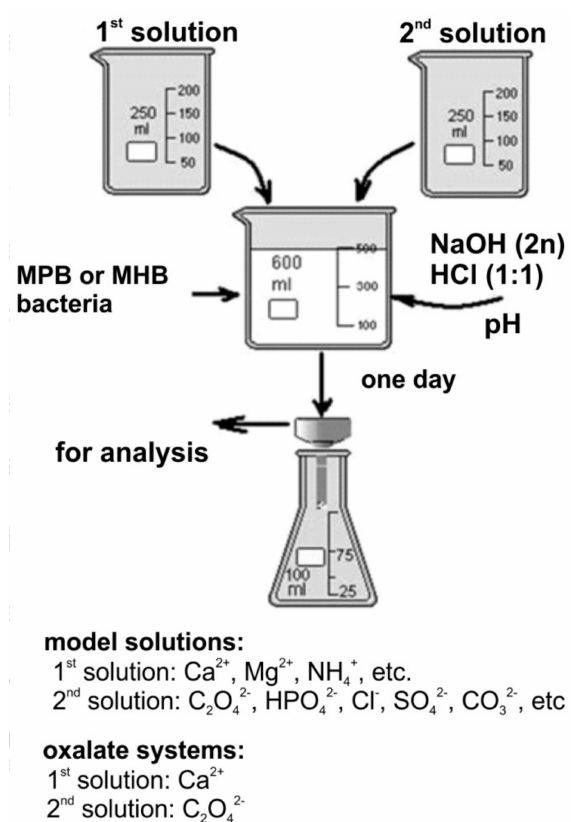
Figure 2. The scheme of the synthesis experiment in system which simulated the composition of urine by inorganic